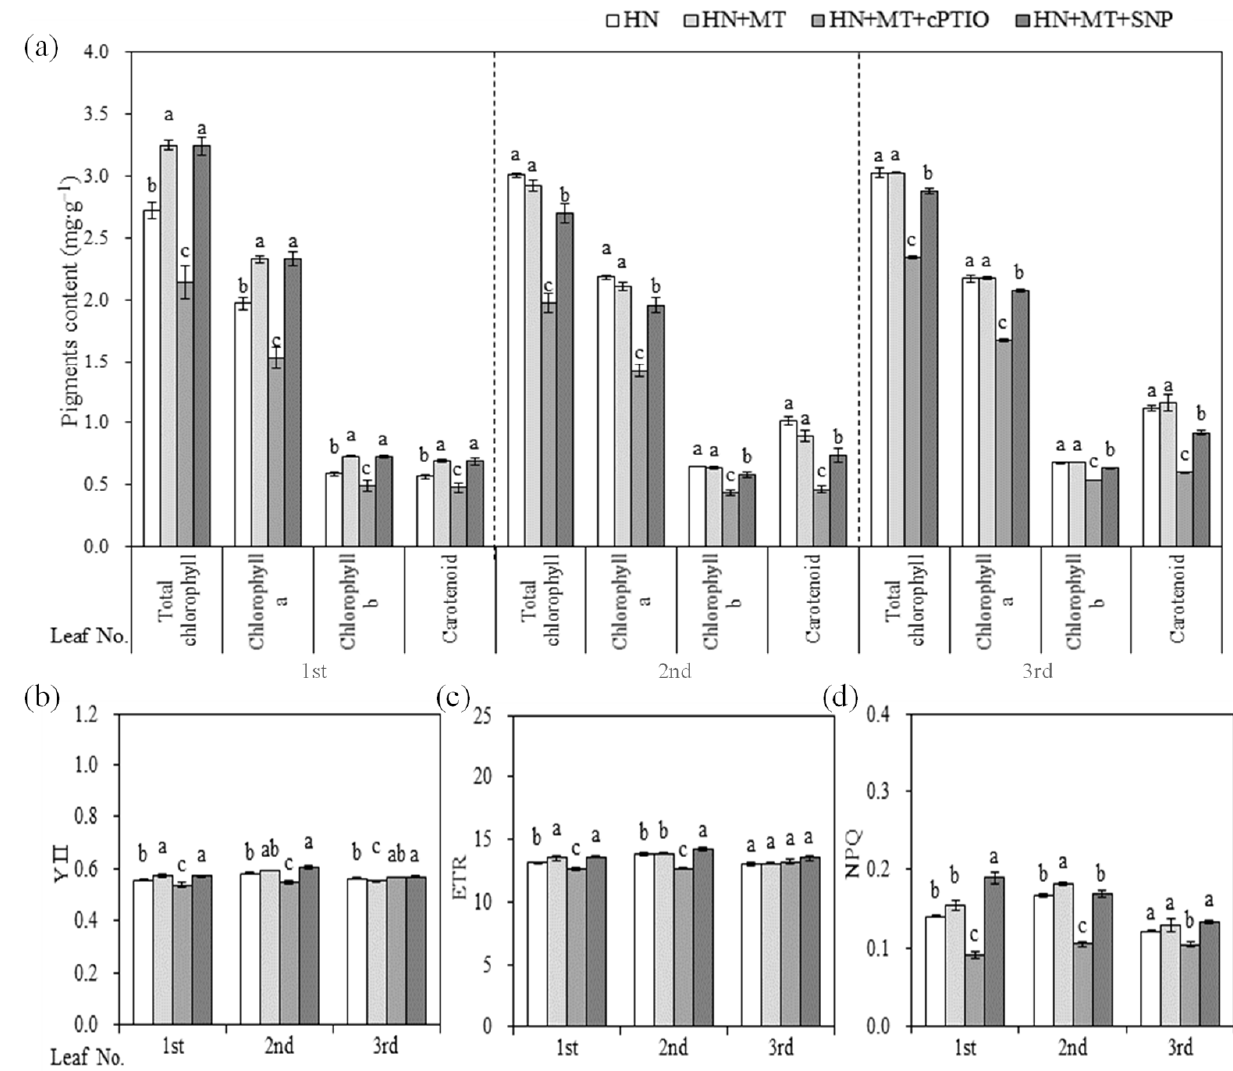
Figure 4. Effects of melatonin and nitric oxide on the pigments content and chlorophyll fluorescence characteristics of cucumber seedlings under nitrate stress. ( a ) Pigments content. ( b ) Effective quantum yield of photochemical energy conversion in PSII (YII). ( c ) Electron transport rate (ETR). ( d ) Non-photochemical quenching (NPQ). Error bars represent standard deviations of the means of three independent replicates. Different letters indicate significant differences between treatments by Duncan’s multiple range test ( p < 0.05).